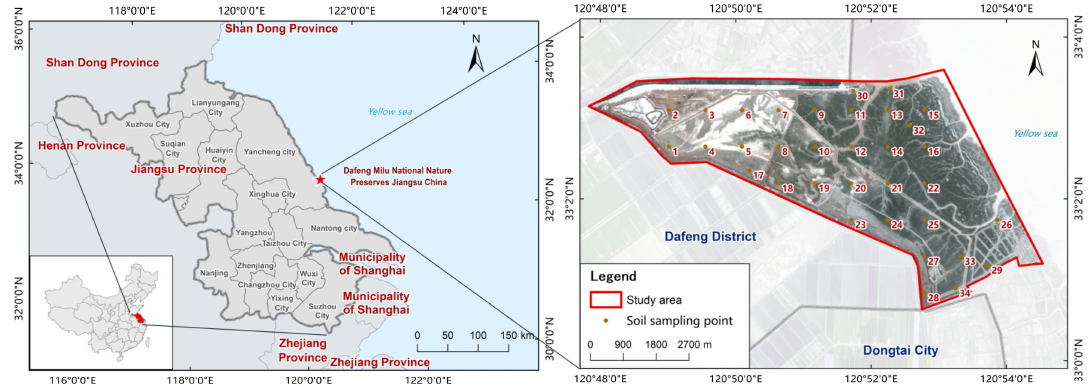
Figure 1. The study area at the Dafeng Elk National Nature Reserve in